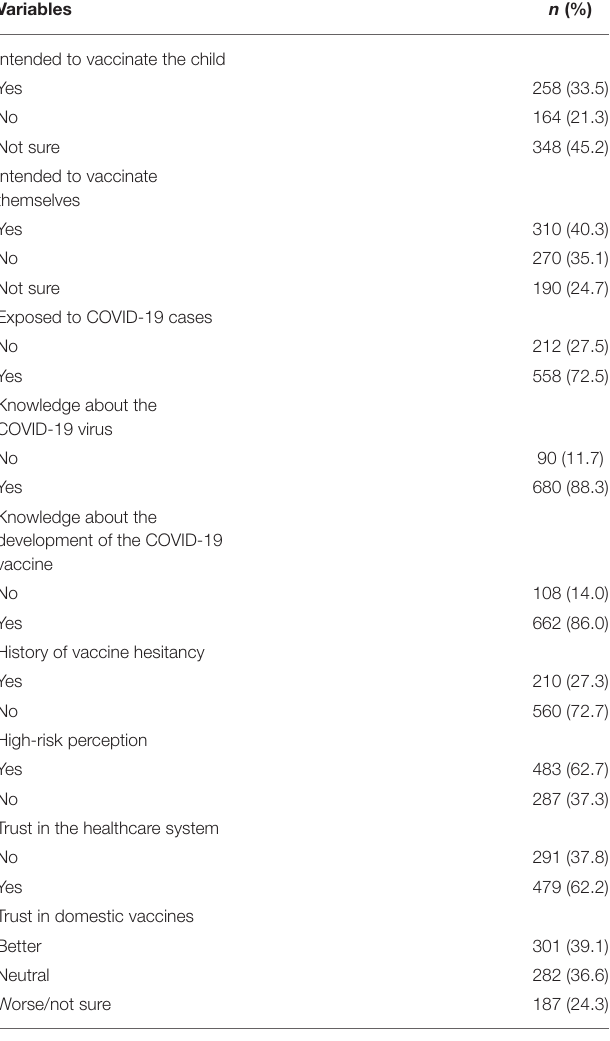
TABLE 2 | Willingness to accept COVID-19 vaccine, contact history with COVID-19 patients, risk perception, and vaccine preferences among parents ( N =